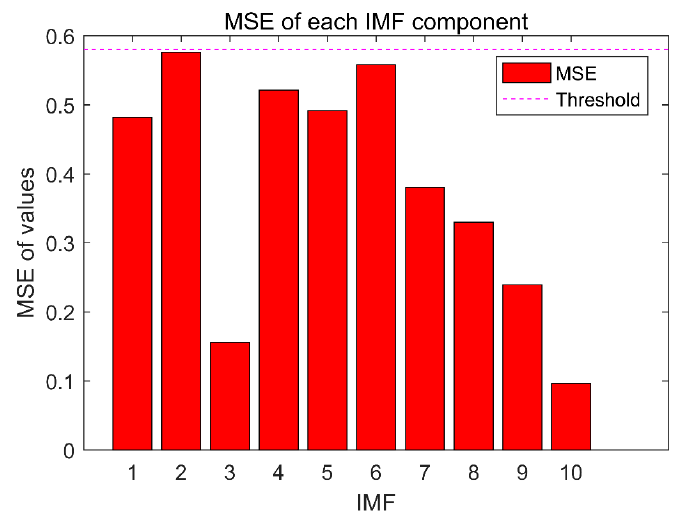
Figure 10. CEEMD decomposition reconstructed signals.